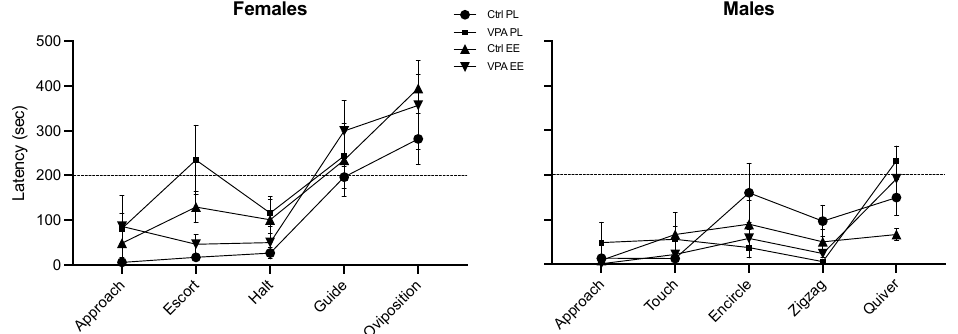
Figure 3. Latency to initiate appetitive, preconsummatory, and consummatory behaviors. Neither treatment nor environment produced significant changes between groups. The female consummatory behaviors were the last executed in all four groups during interplay. Data show the mean ± SEM.